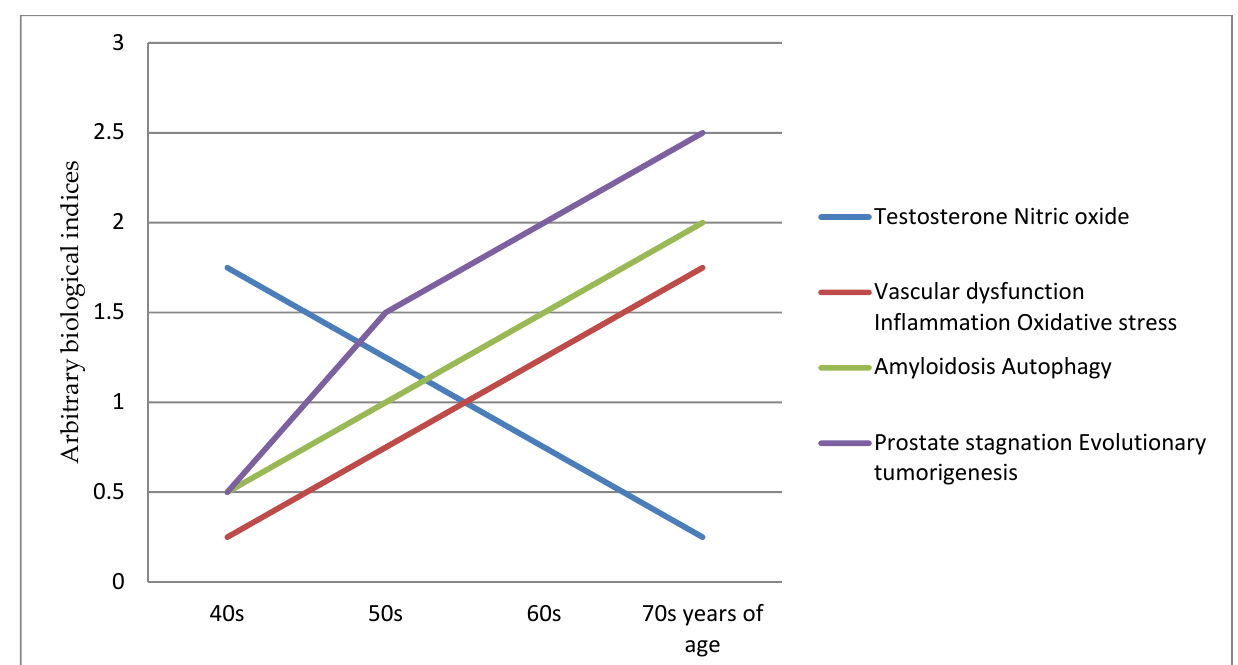
Figure 1. Prostate ageing degeneration hypothesis schematic chart.